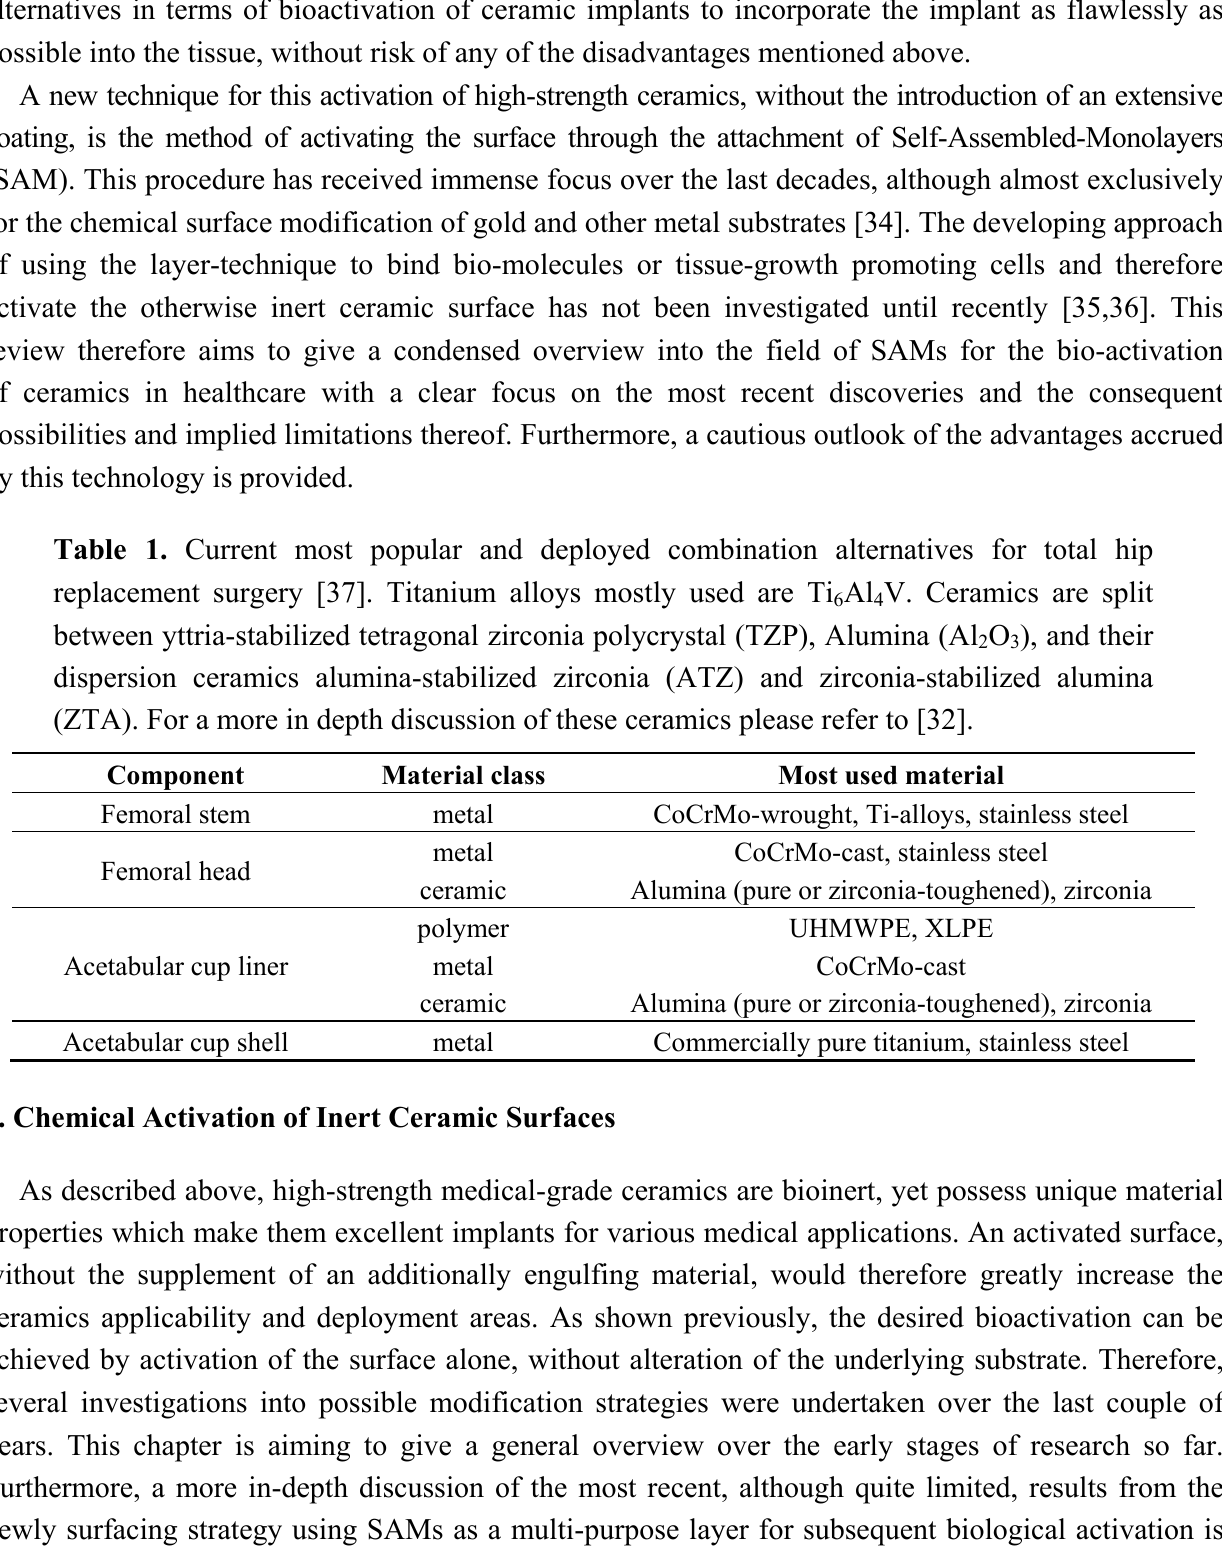
Al V. Ceramics are split 6 4 O ), and their 2 3